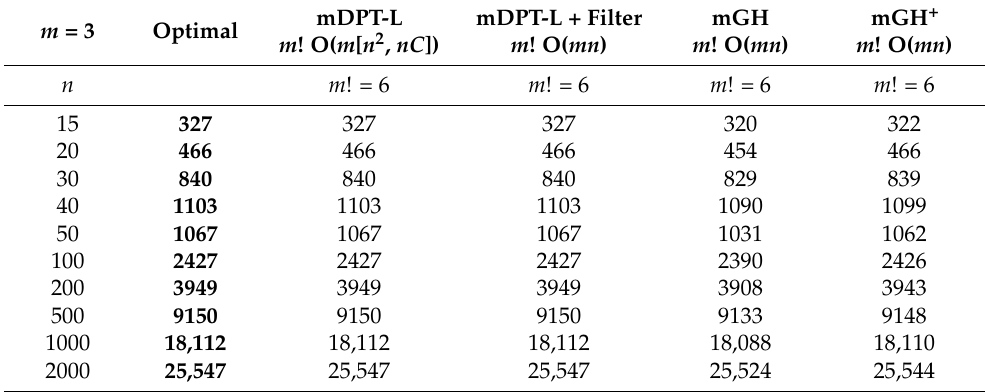
Table 6. Results (total profits) of datasets with capacities C ± 15 ( m = 3).